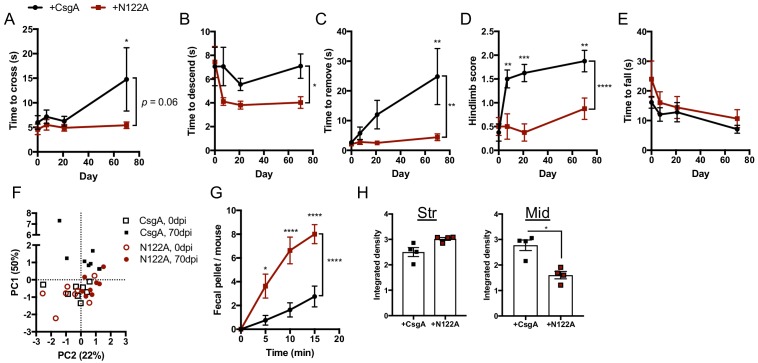
Intestinal injection of amyloidogenic curli promotes progressive motor dysfunction.Conventionally-raised Thy1-αSyn (ASO) mice were injected intestinally with 30 μg of synthetic CsgA hexamer (CsgA; N-QYGGNN-C) or non-amyloidgenic peptide (N122A; N-QYGGNA-C). Motor function assessed overtime at 0, 7, 21, and 70 days post-injection in the (A) beam traversal, (B) pole descent, (C) adhesive removal, (D) hindlimb clasping score, and (E) wirehang tests. (F) Principal component analysis of compiled motor scores of ASO mice. (G) Fecal output observed at day 70 in ASO mice. (H) Quantification of insoluble αSyn fibrils in the striatum and ventral midbrain by dot blot assay. n = 8 (A–G), n = 4 (H). Points represent individuals, bars represent the mean and standard error. Time courses analyzed by two-way ANOVA, with Sidak post-hoc test for between group comparisons indicated above individual time points, and brackets indicating significance between treatments. Data in (H) analyzed by two-tailed Mann-Whitney test. *p≤0.05; **p≤0.01; ***p≤0.001; ****p≤0.0001.Figure 3—figure supplement 3—source data 1.Source data and statistical analysis.